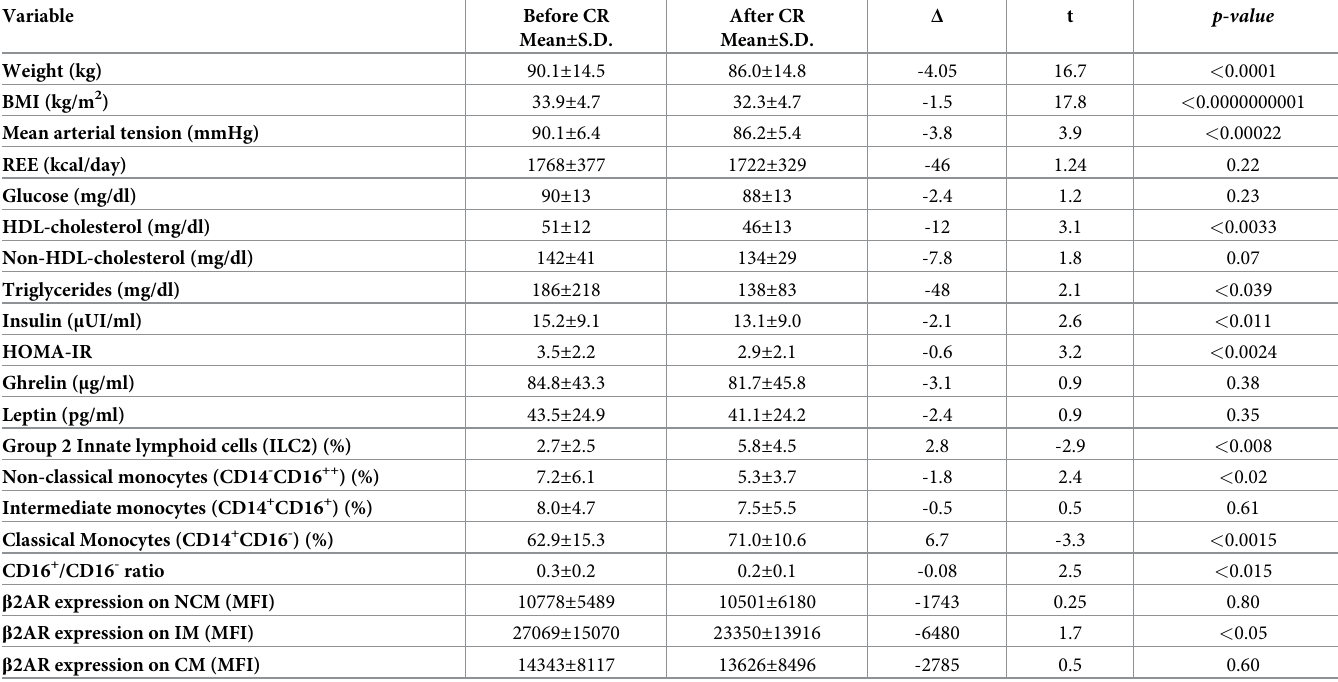
n = 52 obese subjects. Differences between groups were evaluated with Student’s T test. p < 0.05 was considered statistically significant. REE, resting energy expenditure CR, caloric restriction; BMI, body mass index; HOMA-IR, homeostatic model assessment- insulin resistance; EE, energy expenditure; β 2AR, beta-2 adrenergic receptor; NCM, non-classical monocytes (CD14 - CD16 ++ ); IM, intermediate monocytes (CD14 + CD16 + ); CM, classical monocytes (CD14 + CD16 + ); MFI, mean